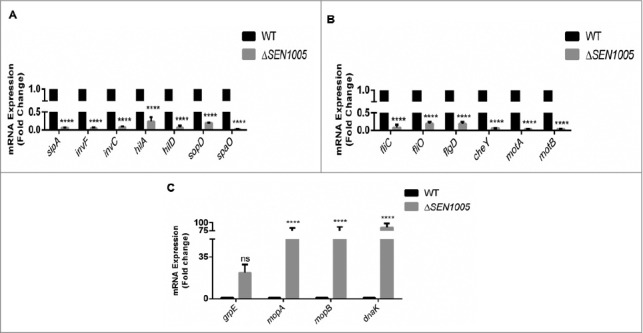
Validation of variable gene expression in WT and ΔSEN1005 through qRT-PCR analysis. (A) Expression of SPI-1 genes in WT vs ΔSEN1005 through qRT-PCR. (B) Expression of genes related to flagellar assembly, bacterial chemotaxis and motility in WT vs ΔSEN1005 through qRT-PCR. (C) Expression of genes related to chaperone family of proteins in WT vs ΔSEN1005 through qRT-PCR. The data was presented corresponding to the fold-change differences in gene expression in ΔSEN1005 with respect to WT. Results were summarized from three independent experiments in triplicates and data represented as mean ± SD. ns, not significant (P>0.05). Statistical significance: *P < 0.05, **P < 0.01, ***P < 0.001, ****P < 0.0001 (Two-way ANOVA).